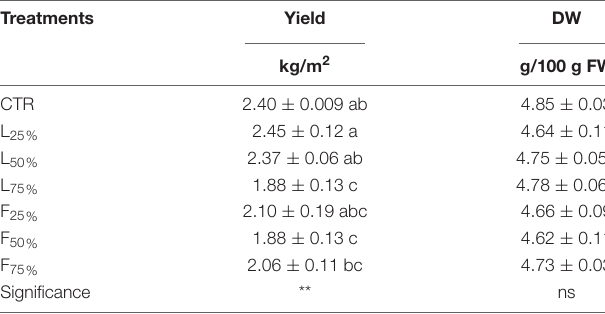
TABLE 3 | Yield and dry weight (DW) of Brassica rapa L. Mizuna group microgreens as effected by Posidonia oceanica (L.) Delile (PO) leaves (L) and fibers (F) in the growing media